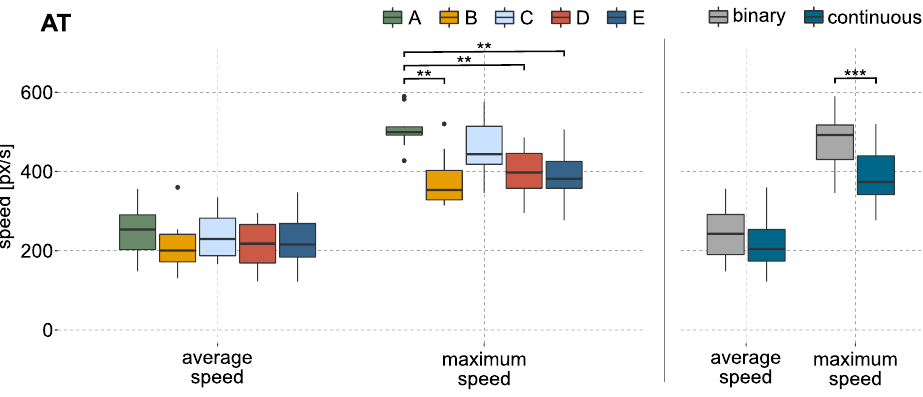
Figure 6. Results of average and maximum speed over all subjects during AT, based on the mean values of each subject per labeling method. ( Left ): boxplot of the average speed and maximum speed in px/s during the gross motion section of the AT. A significant difference was identified for maximum speed (A-(B, D, E) by the KW test. ( Right ): boxplot for the average and maximum speed during the gross motion for methods based on binary and continuously labeled data. A significant difference was identified for maximum speed. ‘ • ’ indicates outliers; ‘*’ indicates statistical significance (‘*’ p < 0.05, ‘**’ p < 0.01, ‘***’ p < 0.001).